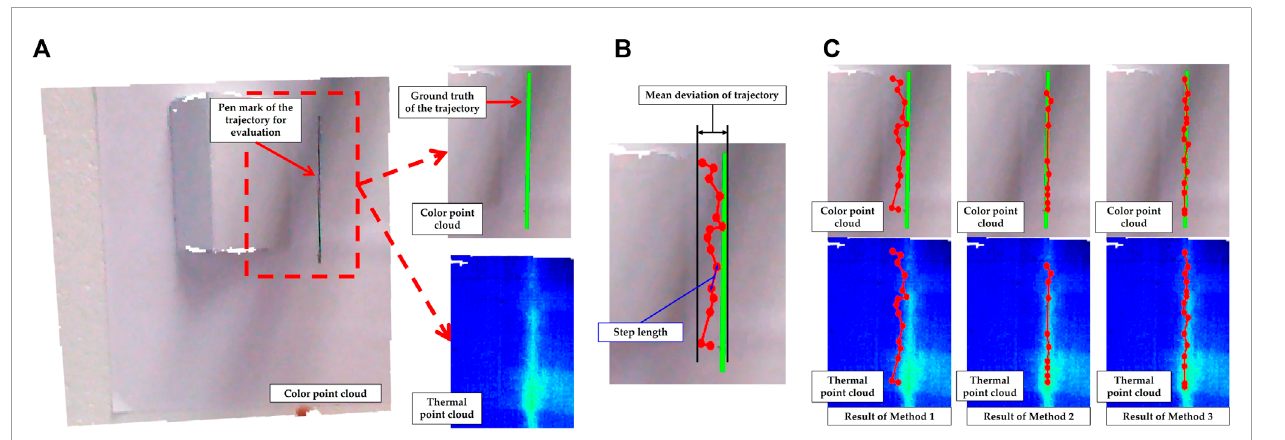
FIGURE 9 (A) Shows the straight line pen mark on the object surface (left), the ground truth of finger movement (top left) and the correspondent thermal point cloud (B) shows the evaluation criteria (Mean deviation of the trajectory and step length between each two adjacent contact points of the trajectory)